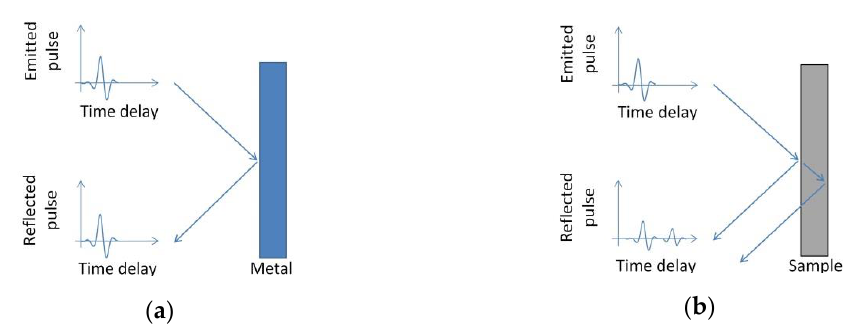
Figure 3. ( a ) The THz pulse emitted by the PCA is focused on a metal plane surface, the reflected pulse is considered equivalent to the emitted one; ( b ) reflection from a sample placed in the same position of the metal surface, the reflected signal comprises two pulses originating from the reflections at air/sample and sample/air interfaces.